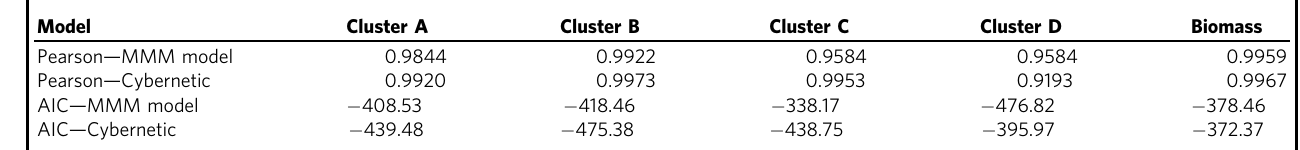
Table 2 R 2 and AIC calculation for the different simulations using the two different models. Model Cluster A Cluster